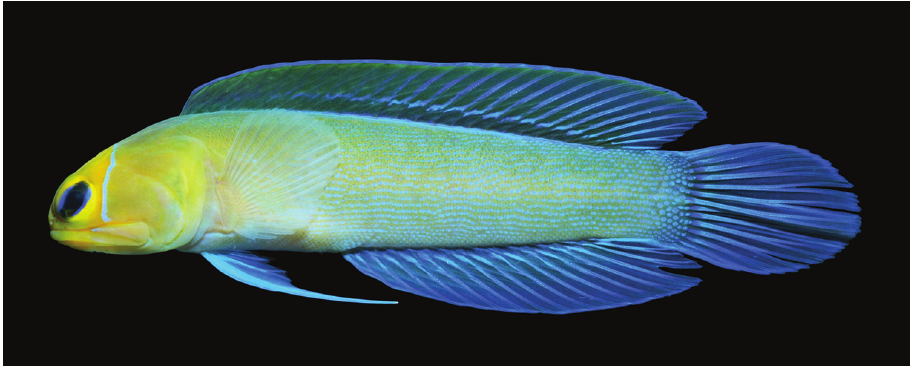
Figure 18. Opistognathus aff. aurifrons , CIUFES 0795-1, 61.8 mm SL, female, Ilhas Escalvada, Guara- pari, Espírito Santo, Brazil. Photograph by Raphael M. Macieira.